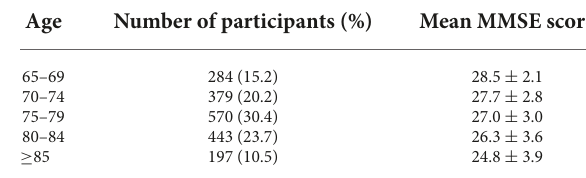
TABLE 2 The population and mean MMSE scores of each age group.